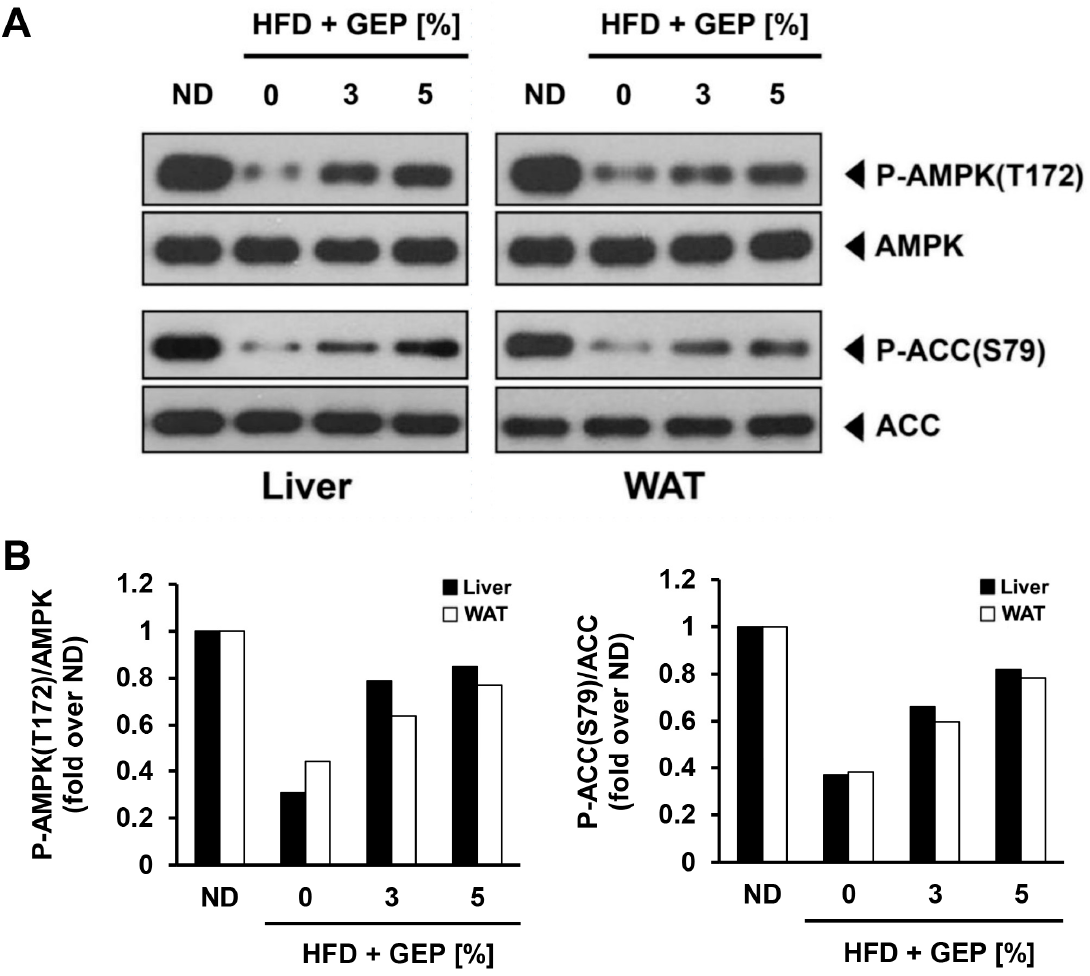
Figure 9. E ff ect of GEP on AMPK and ACC protein expression and activation. ( A ) Western blot analysis and the phosphorylation ratio of ( B ) AMPK and ACC in the liver and WAT of HFD-induced obese mice stated in fold over